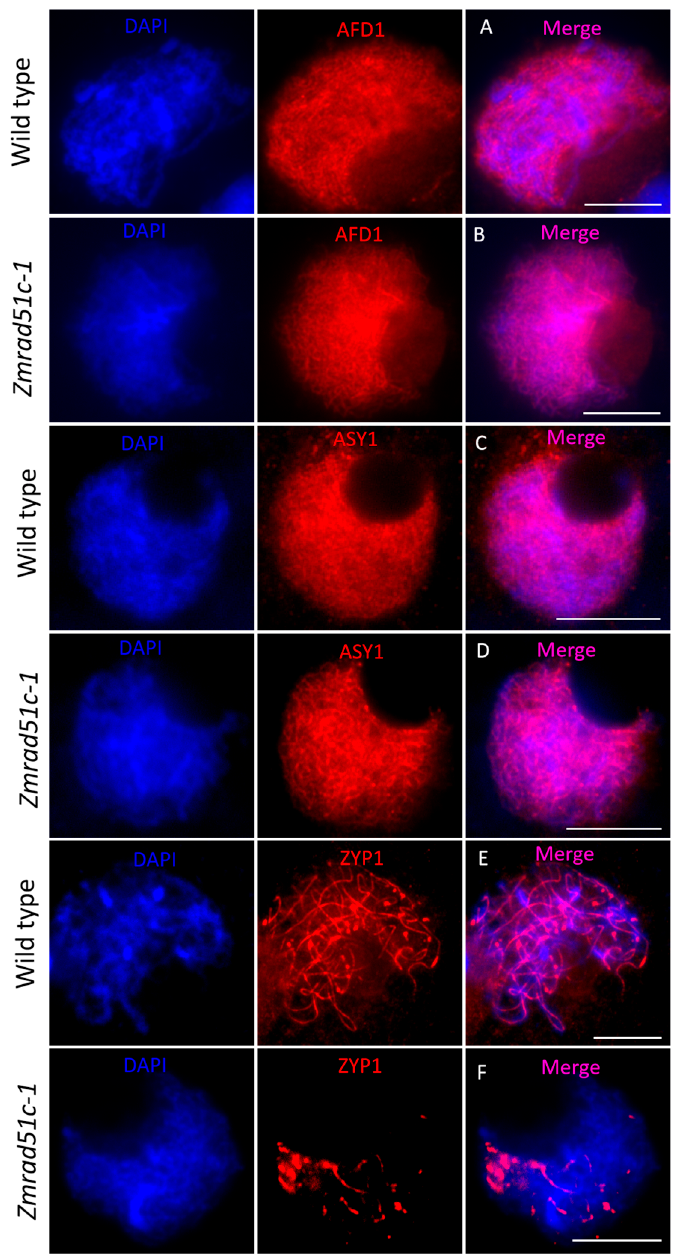
Figure 5. Immunolocalization of SC complex AFD1, ASY1, and ZYP1 proteins in wild type and Zmrad51c-1 . Scale bars = 10 µm. DAPI staining was used to indicate the chromosomes. AFD1 ( A ), ASY1 ( C ), and ZYP1 ( E ) in wild type meiocytes; AFD1 ( B ), ASY1 ( D ), and ZYP1 ( F ) in Zmrad51c-1 meiocytes.